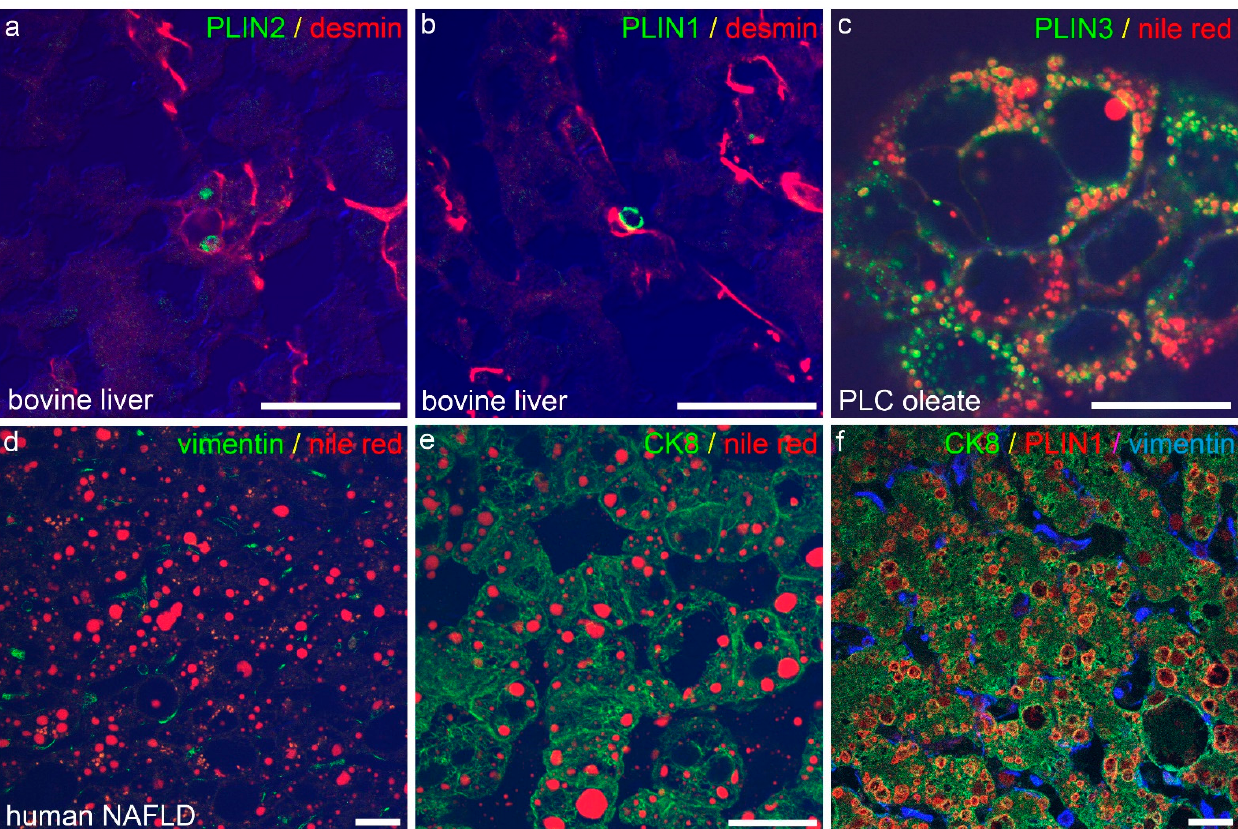
Figure 1. Immunofluorescence microscopy of LDs and perilipins in the liver. ( a , b ) Confocal laser scanning fluorescence microscopy of perilipin 2 (( a ), PLIN 2, green) and perilipin 1 (( b ), PLIN1, green) mark LDs in desmin (red)-positive, non-parenchymal HSC in cryopreserved normal bovine liver. Note absence of perilipin 1 and 2-positive LDs in parenchymal cells of normal bovine liver. ( c ) Perilipin 3 (PLIN3, green) localizes to the rim of Nile red (red)-positive LDs in oleate-treated cultured cells of the HCC-derived line PLC. ( d – f ) Accumulation of Nile red (red)-positive LDs in human NAFLD is attributed to fatty change in hepatocytes (( e ), CK8, green), whereas HSC (( d ), vimentin, green) show no Nile red-positive LDs. As an example, perilipin 1 (PLIN1, red) localizes to LDs in CK8 (green)-positive hepatocytes, but not to vimentin (blue)-positive HSC. Merge images in ( a , b , d , e ) include differential interfering contrast. Scale cars: each 25 µm.